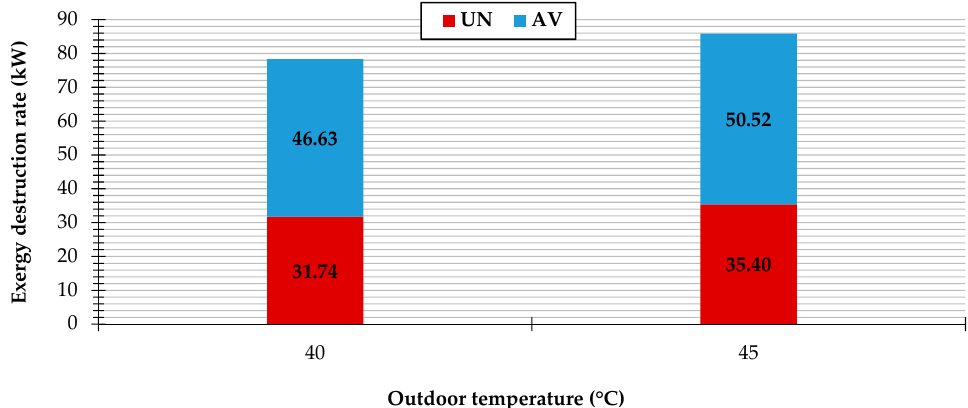
Figure 10. Effect of the outdoor temperature on the avoidable and unavoidable exergy destruction rates of the investigated system.